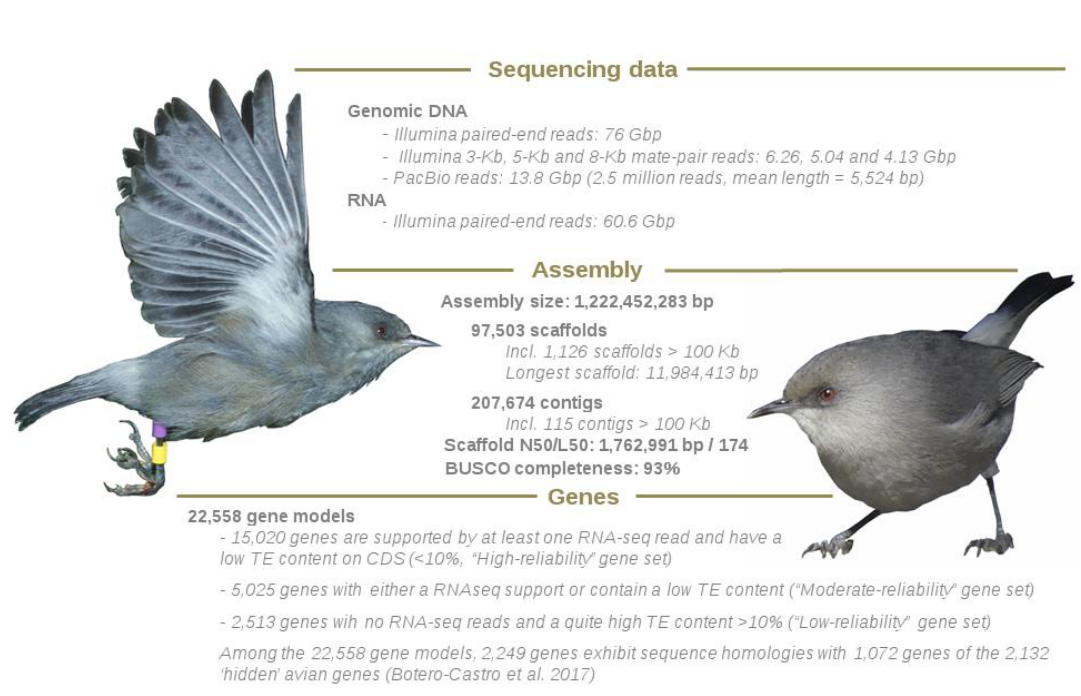
Figure 1. Z. borbonicus genome assembly and gene model summary statistics. The reported numbers of reads and the total numbers of bases sequenced correspond to the trimmed reads. The three different gene sets are indicated as specified in the gff file. Photo credits: Maëva Gabrielli & Laurent Brillard (http://laneb.re).